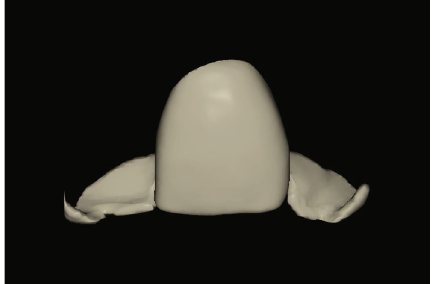
Figure 6: CAD temporary shell restoration with two lateral wings to aid seating.